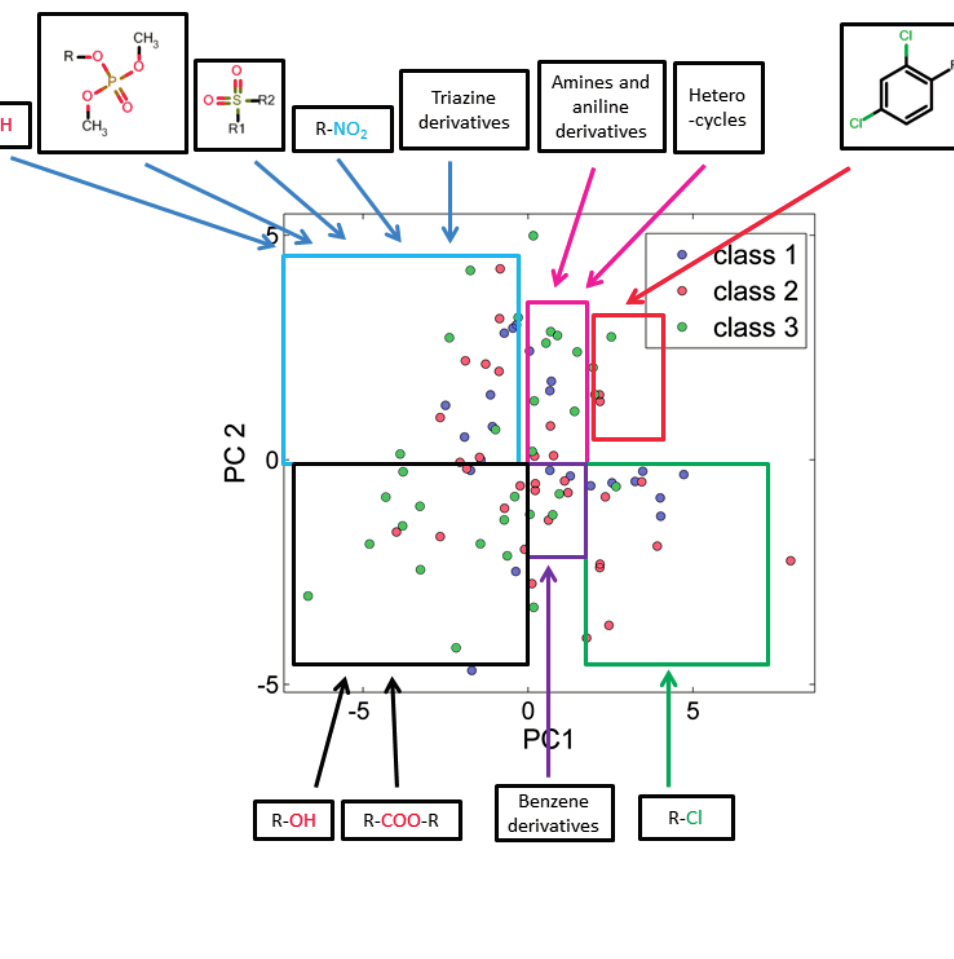
Figure 2. PCA score plot using 25 descriptors explains similarity and variability in test set chemicals with respect to their corresponding